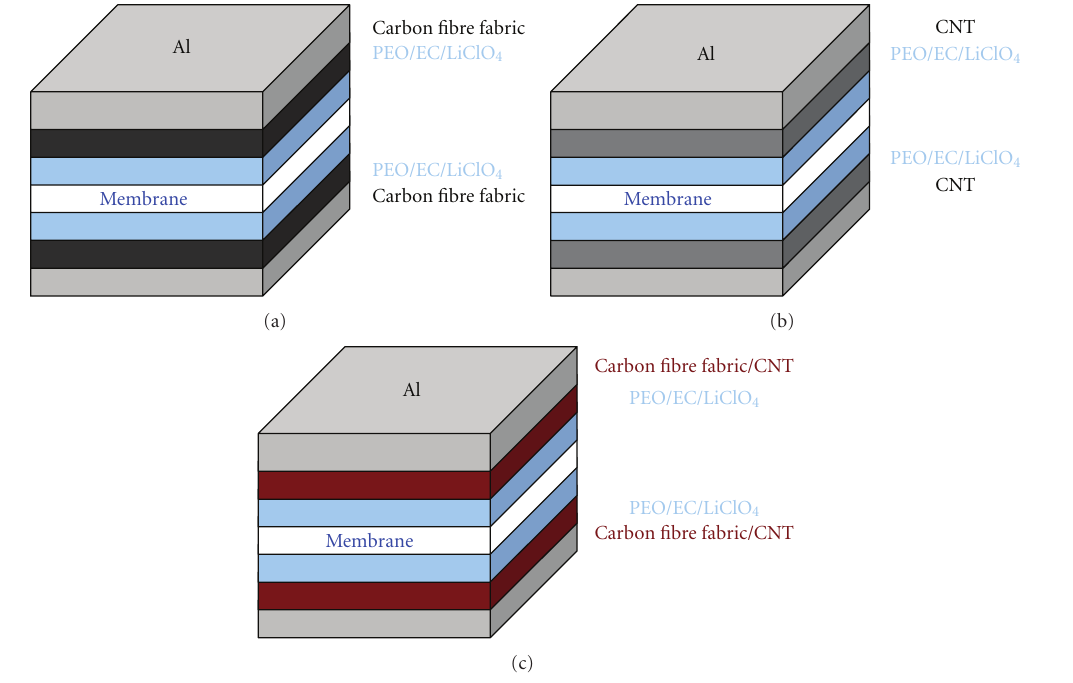
Figure 1: Diagrams of EDLC cells fabricated and tested in this